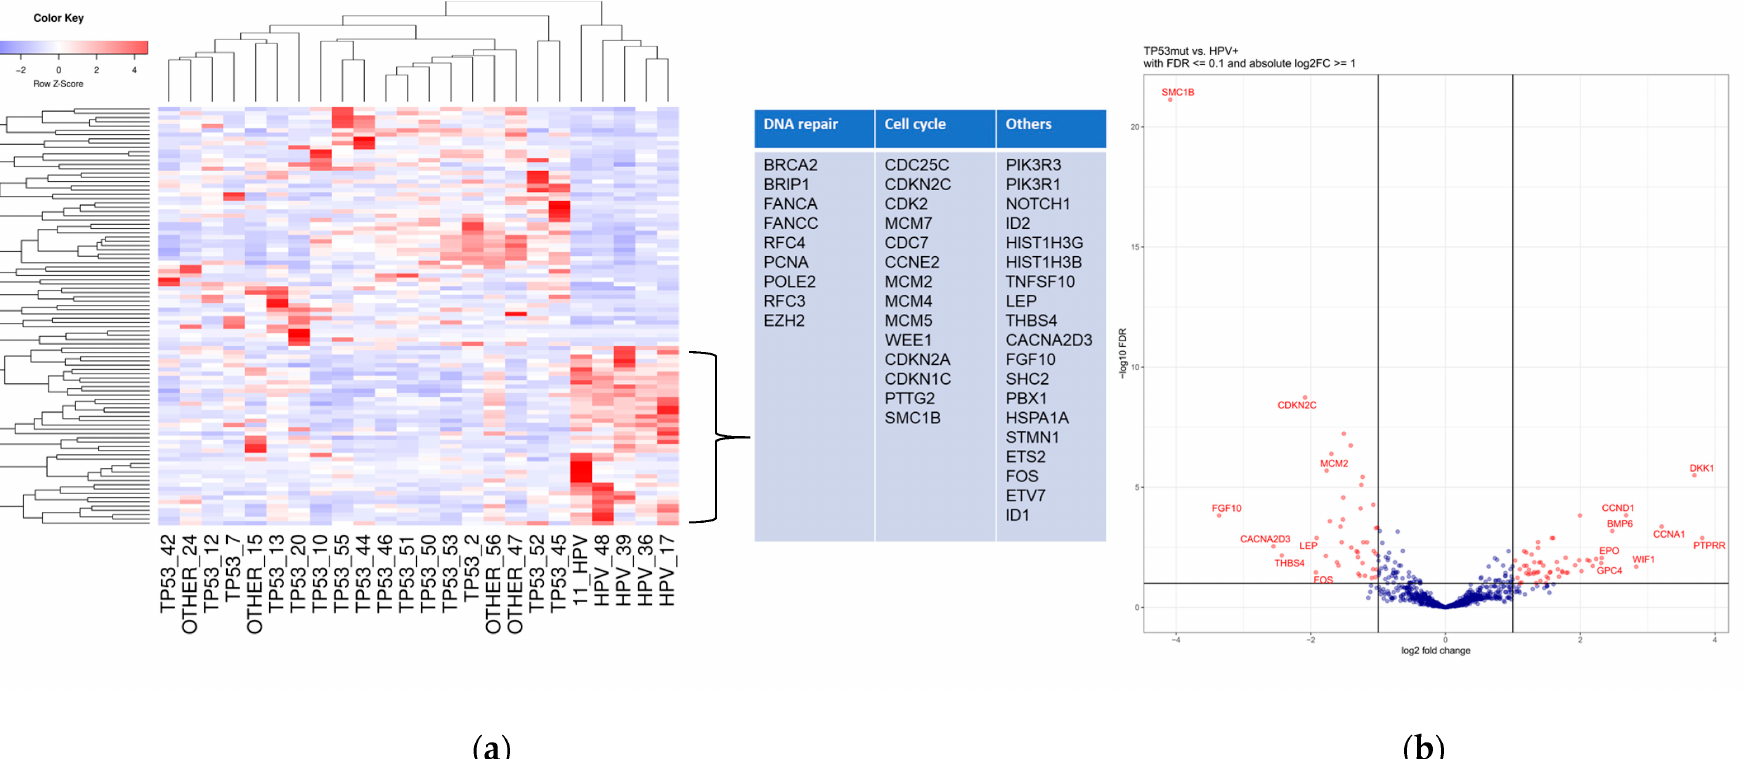
Figure 1. Depiction of the significantly differentially expressed genes. ( a ) Heatmap depicting the expression profiles of the genes that are significantly differentially expressed, |log2FC| ≥ 1.0 and FDR ≤ 0.1, between the two cohorts. The genes and samples were hierarchically clustered, according to the expression profiles, using complete linkage clustering. The corresponding dendrograms are shown on the left and at the top of the plot, respectively. The table includes all 42 genes that are significantly higher expressed in HPV+ vs. TP53mut VSCC. A complete list of all genes (upregulated, downregulated, and not differentially expressed) and the corresponding analysis results are provided in Table S2. ( b ) Volcano plot depicting the change of expression of genes with their significance for the comparison of TP53mut and HPV+ cohorts. Significantly differentially expressed genes are shown in red. The eight genes with the greatest positive and the eight genes with the greatest negative log2FC were labeled.